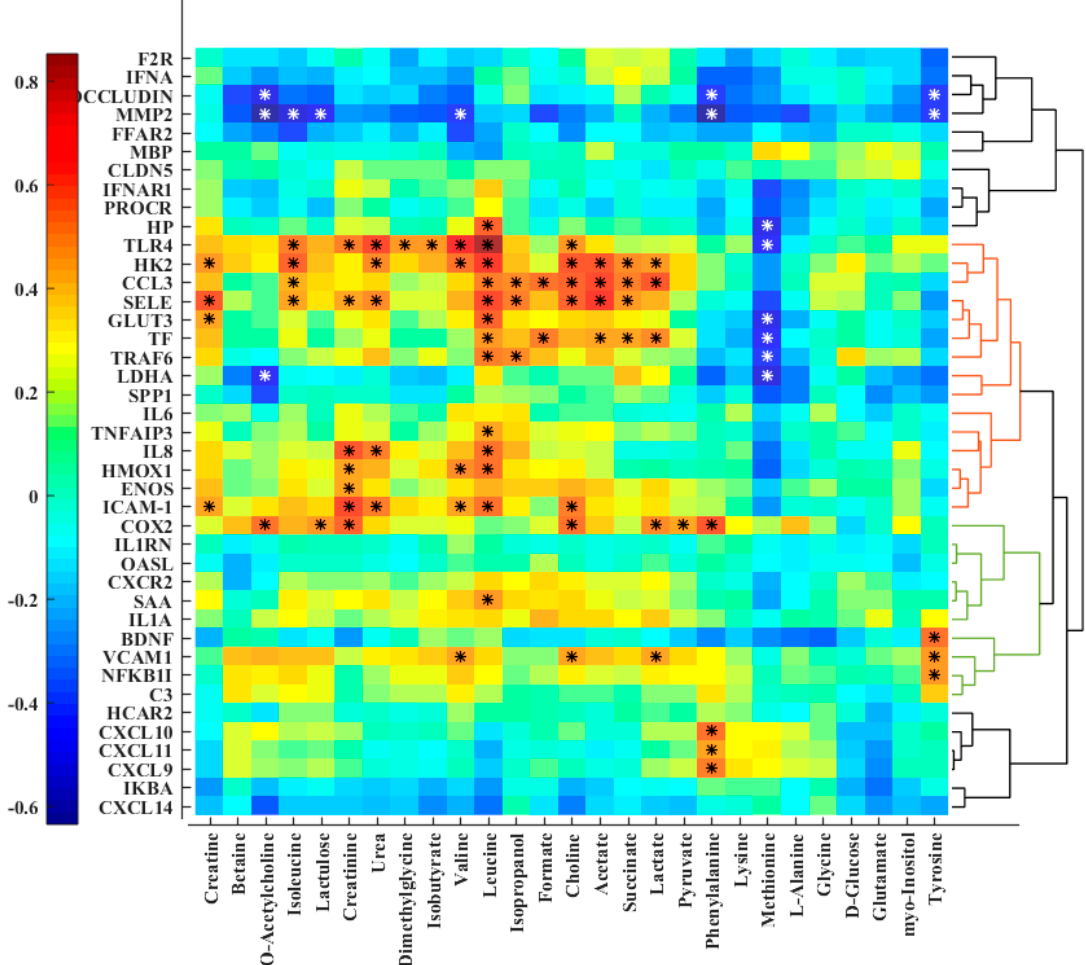
Figure 5. Heat map of correlation analysis between the quantified plasma metabolites and hippocampal gene expression data. The genes were clustered and re-ordered based on the correlation in their expression profiles by hierarchical cluster analysis (HCA). Stars indicate significant correlations ( p < 0.05).